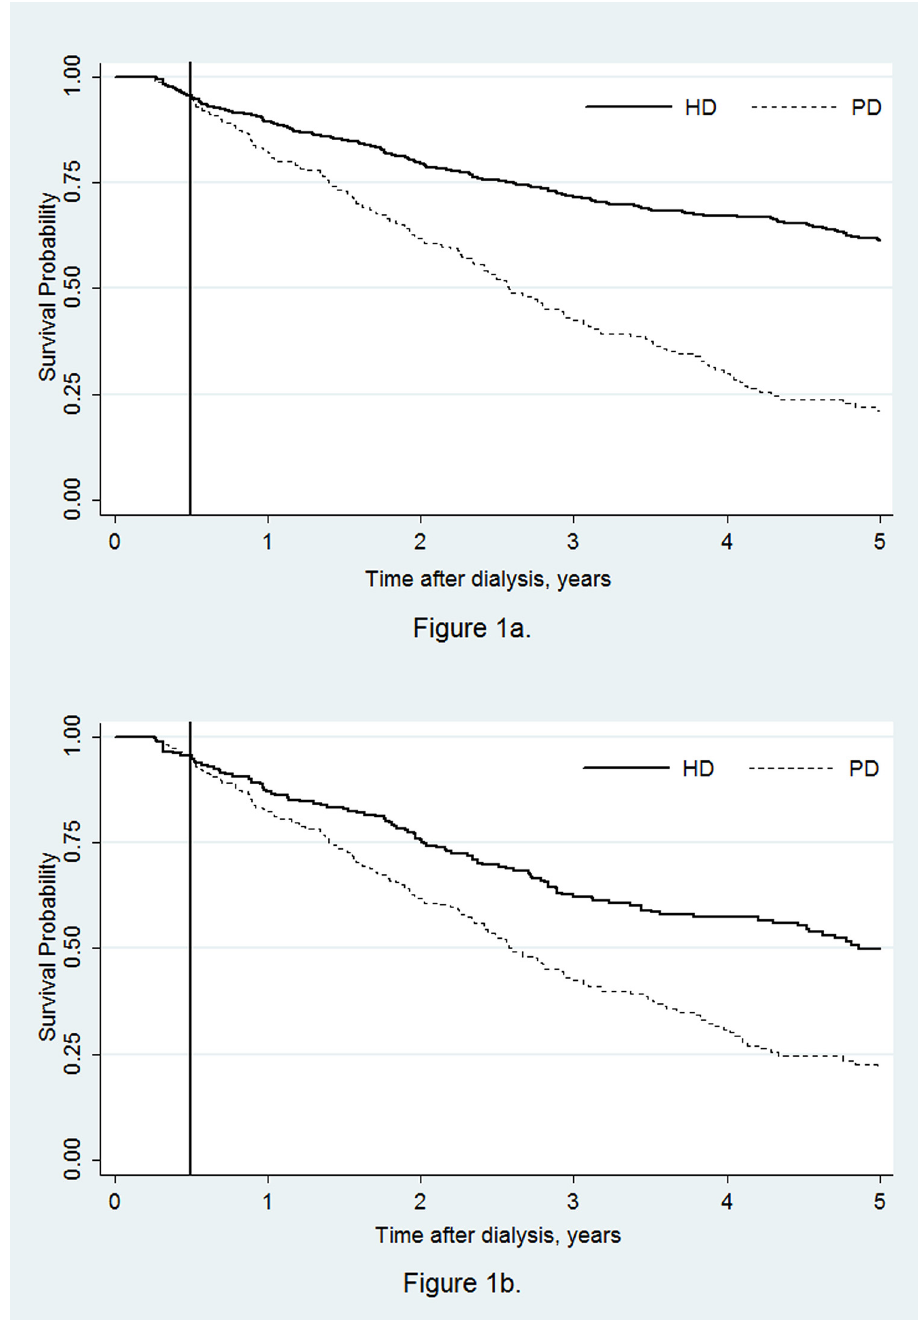
Fig 1. Kaplan-Meier survival curves by initial modality from day 90, using the entire cohort (Fig 1a, HD: 641, PD: 230) and the propensity score matched subsample (Fig 1b, HD: 225, PD: